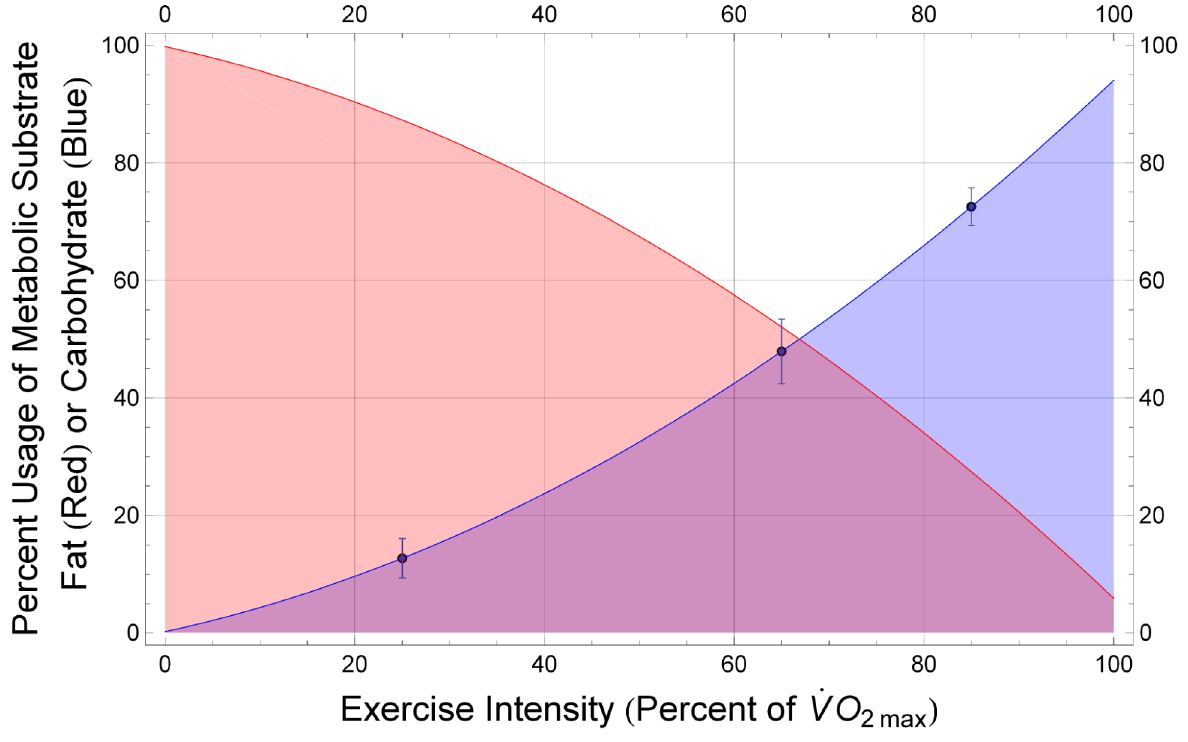
Figure 1. Relative use of fat and carbohydrate as metabolic fuels depends on exercise intensity. Fractional usage of carbohydrate (plasma glucose plus muscle glycogen, blue filled curve, f c ( i ) ) and fat (plasma free fatty acids plus muscle triglycerides, red filled curve, f f ( i ) ~ 1 { f c ( i ) ) are shown as functions of relative exercise intensity, i ~ % _ VVO 2 max . (Based on the work of Romijn and colleagues: Points plotted correspond to data points from the 1993 study [24], and corresponding error bars are computed as described in the Methods section.)